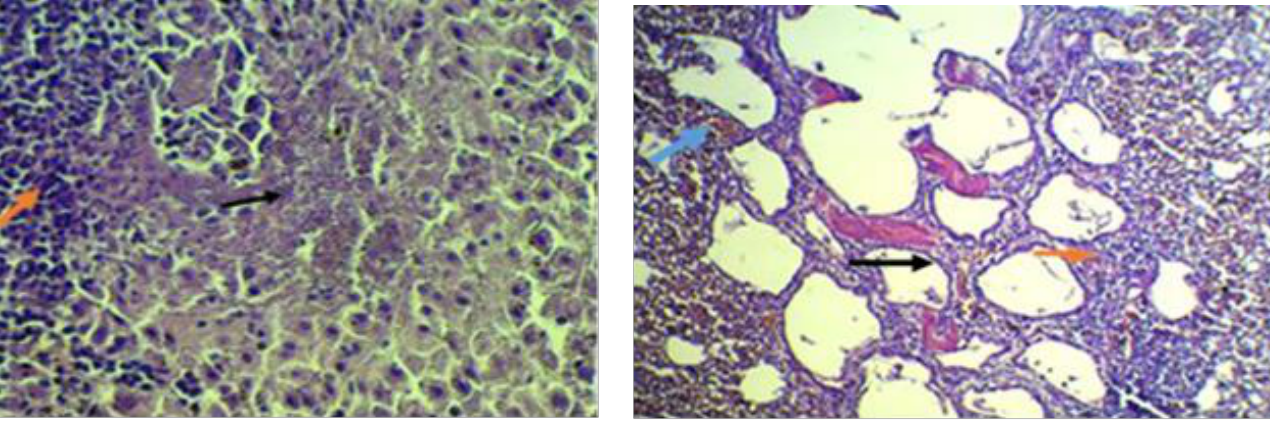
Figure17. Histopathological section of lung of chicken shows congestion of blood vessels ( ) with deposition of hemosiderin ( ) and thickening in Para bronchial wall due to inflammatory cells infiltration (